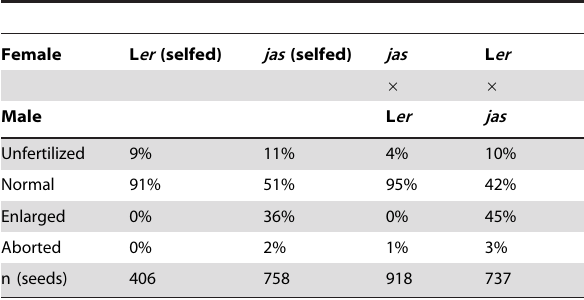
Table 1. Seed phenotype of reciprocal crosses between jas and wild-type